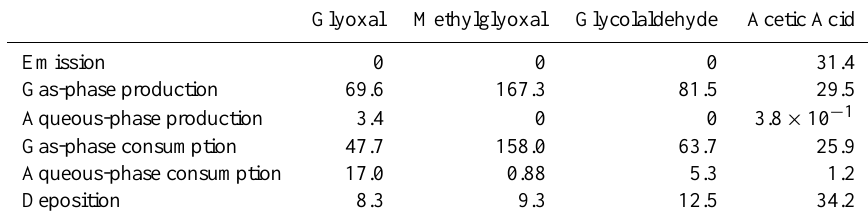
Table 4. Global budgets of aqSOA precursors (Tgyr − 1 ) for Case